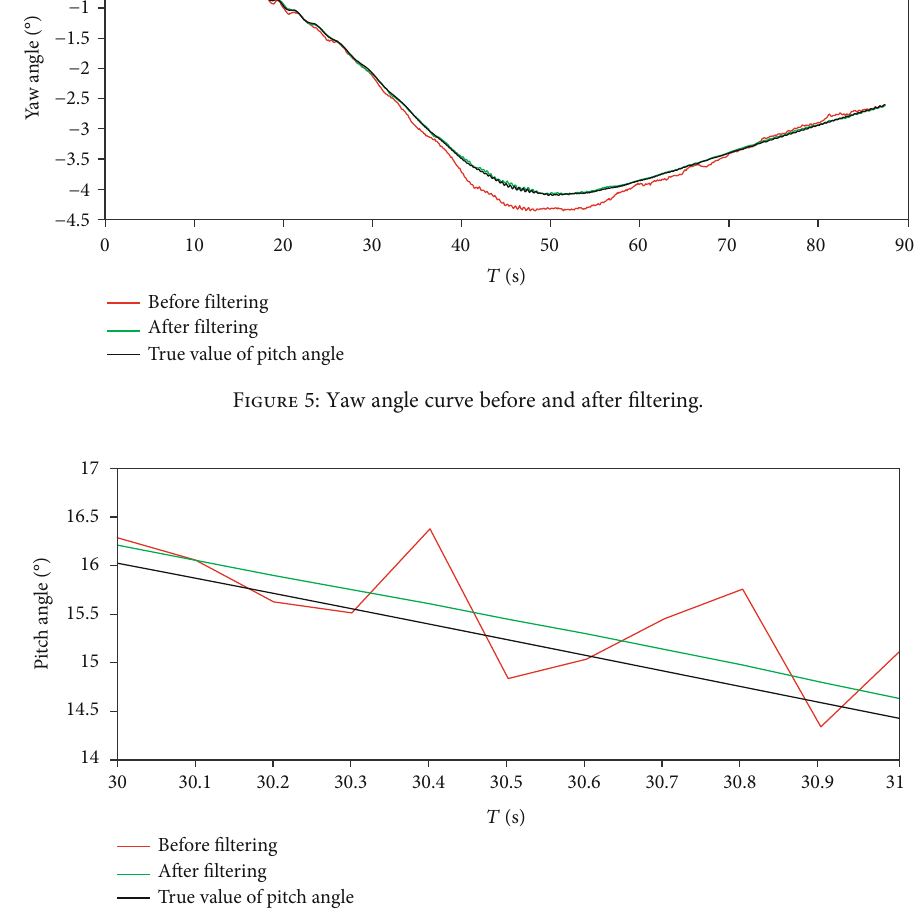
Figure 6: Pitch angle curve of fl ight time between 30 s and 31 s.